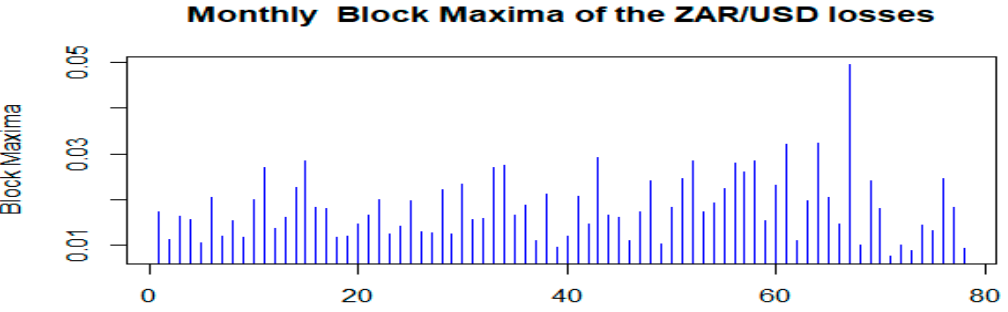
Figure 8. Block maxima for lower tail (losses) of ZAR/USD.